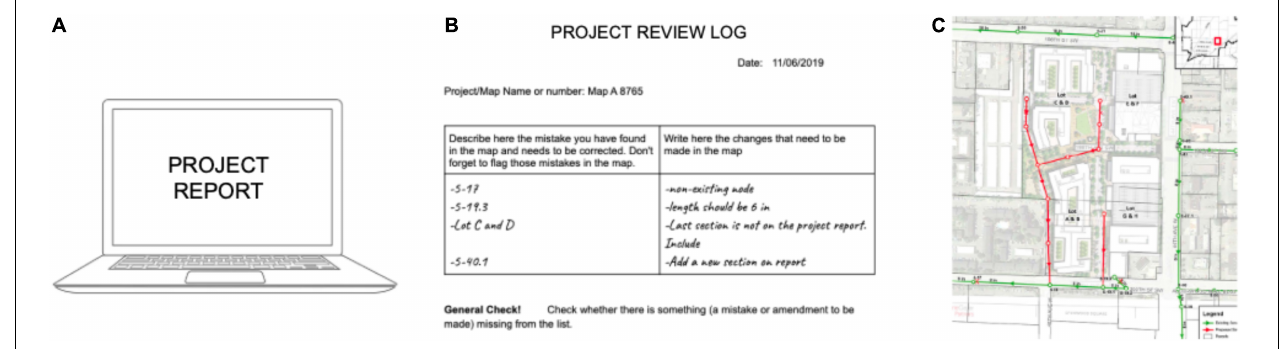
FIGURE 3 | Work set up. Mrs. B used a project log (B) to fix and organize information related to the comparison between a map (C) and its project report (A) . Discrepancies were written down in the log (B) as well as necessary amendments. Information about these discrepancies was later passed into a revised version of the project